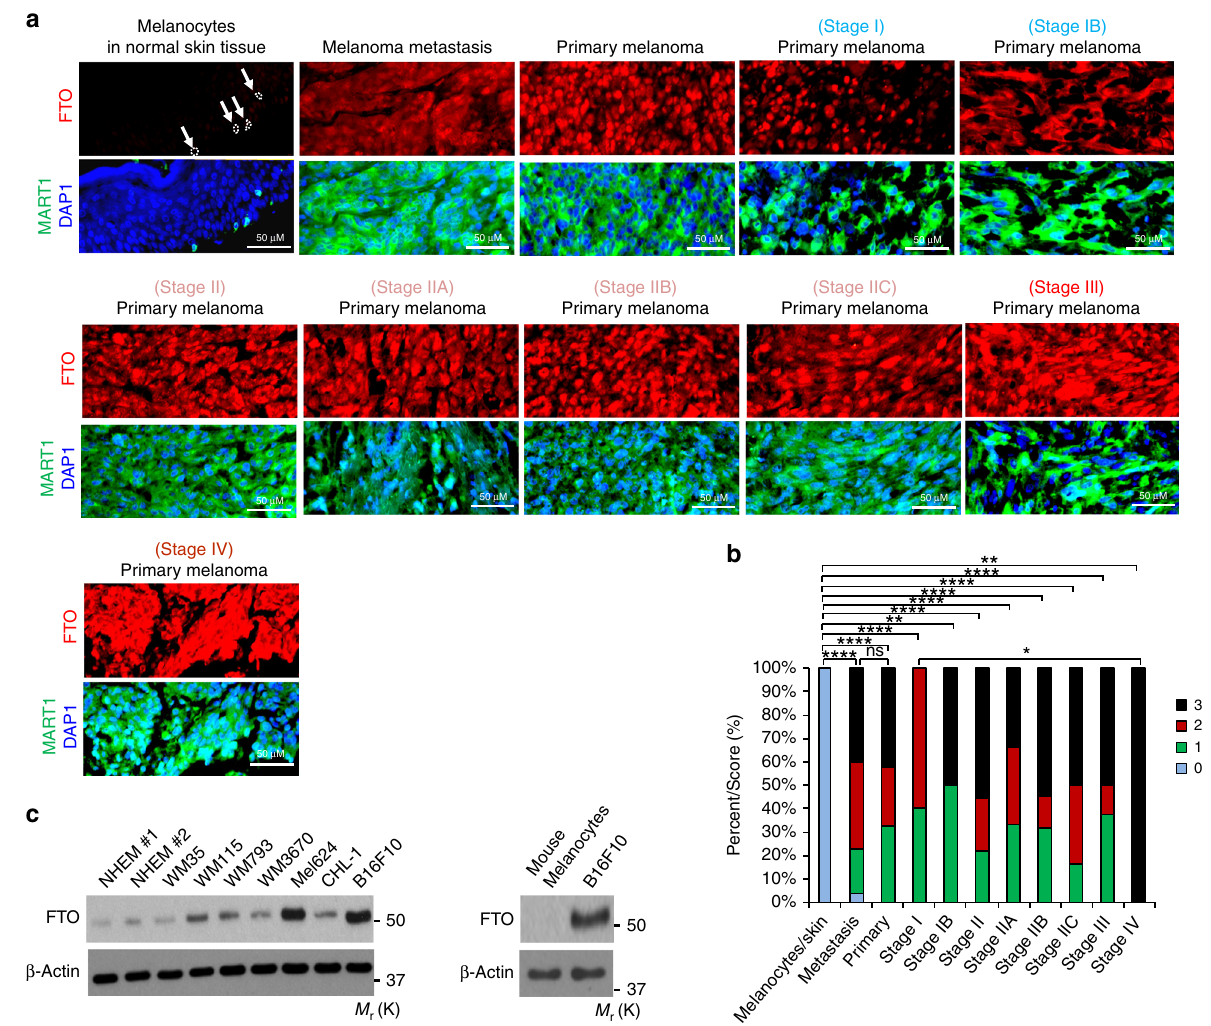
Fig. 1 FTO is upregulated in human melanoma. a Immuno fl uorescence staining of FTO and MART1 in normal human skin and melanoma tissues. Nuclei are counterstained with DAPI in blue. Scale bar, 50 μ m. The arrows indicate representative melanocytes in normal human epidermis. b Percentage of tumors (in stacked column format) for each score of FTO. 0 (Negative), 1 (Weak), 2 (Medium), and 3 (Strong); * P < 0.05; ** P < 0.01; **** P < 0.0001; ns, P > 0.05, not signi fi cant; Mann – Whitney U- test. c Immunoblot analysis of the protein levels of FTO, and β -actin (loading control) in normal melanocytes and melanoma